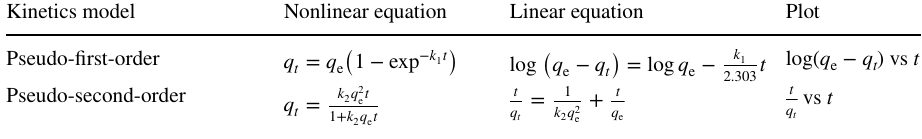
where q t and q e are amount of dye adsorbed per unit of adsorbent at equilibrium and at time t , and k 1 and k 2 are pseudo-first-order and pseudo-second-order rate